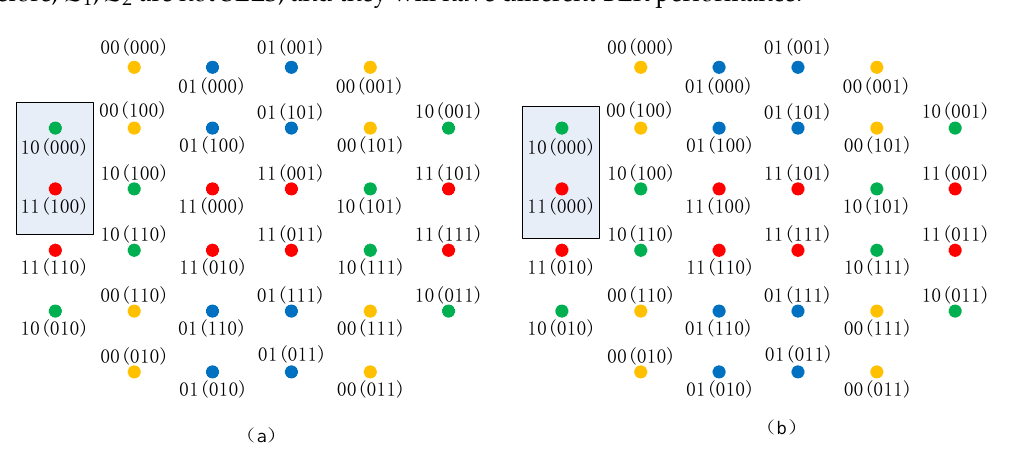
Figure 4. An example CELS. ( a ) The labeling L 1 . ( b ) The labeling L 2